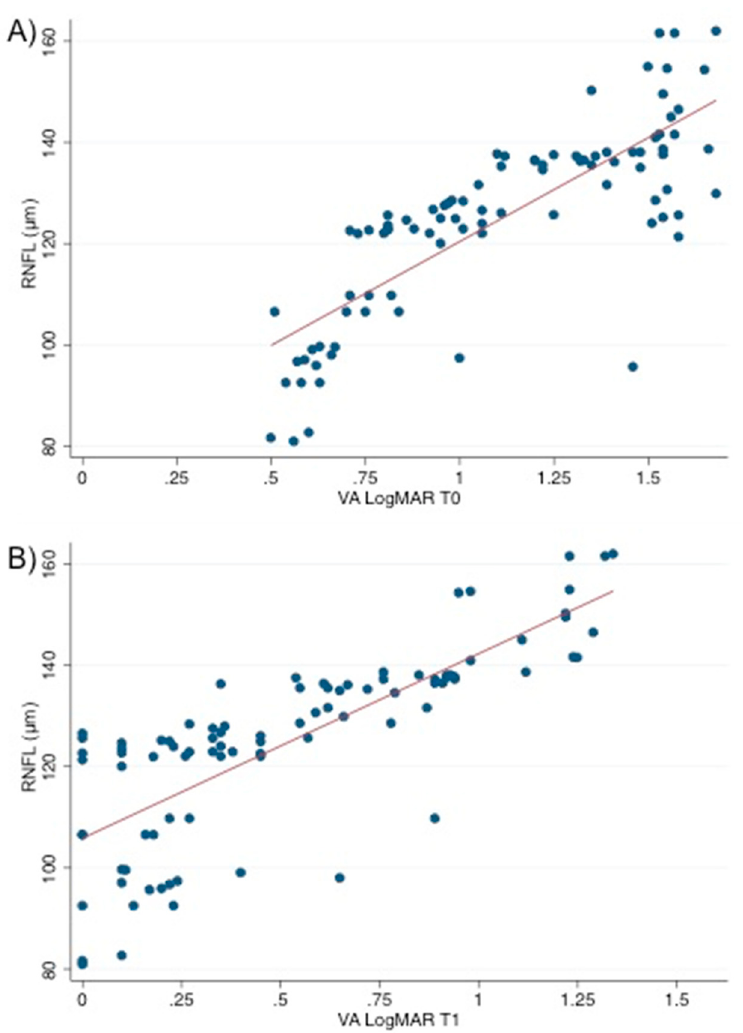
Figure 2. Correlation between retinal thickness and visual acuity in ON eyes. This figure shows the positive correlation ( A ) between retinal nerve fiber layer (RNFL) at T0 and visual acuity converted to the logarithm of the minimal angle of resolution (VA LogMAR) at T0 ( r = 0.89; p < 0.0001) and ( B ) between retinal nerve fiber layer (RNFL) at T0 and visual acuity converted to the logarithm of the minimal angle of resolution (VA LogMAR) at T1 (r = 0.87; p < 0.005). RNFL: retinal nerve fiber layer; VA LogMAR: visual acuity converted to the logarithm of the minimal angle of resolution. The reported data refer to the whole sample (n = 90). The p -value obtained through Spearman’s correlation analysis is also shown.